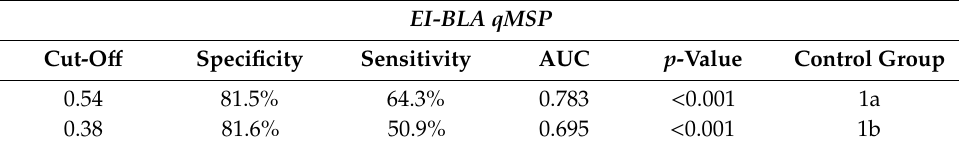
Table 1. EI-BLA biomarker performance based on training cohort #1 as compared to di ff erent control groups.